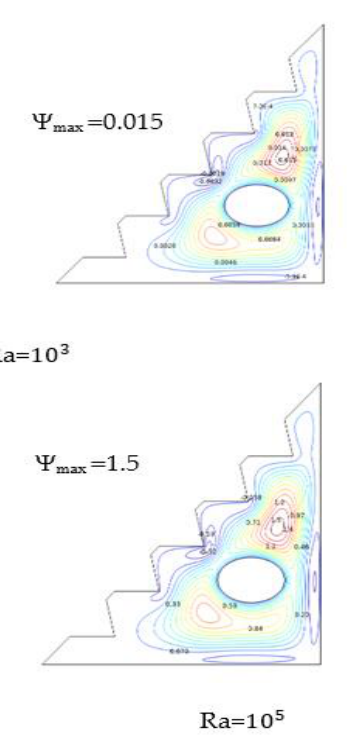
Figure 5. Streamlines and isotherms for Ra = 10 5 , Ha = 0, and w = 0.